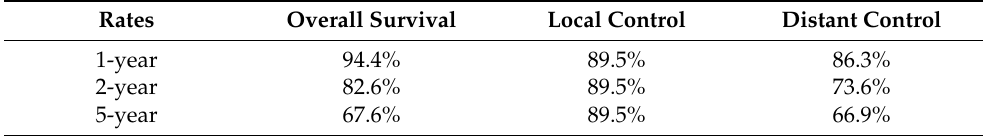
Table 3. Outcome with Kaplan–Meier